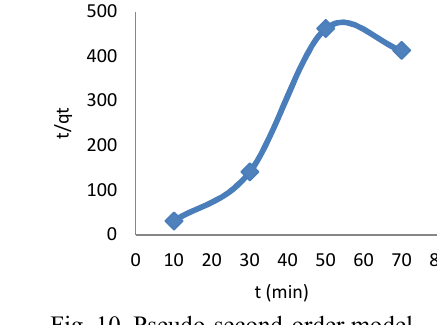
Fig. 9. Pseudo-first-order model Fig. 10. Pseudo-second-order model Table 3. Rate of adsorption kinetic model constants for copper ion removal Pseudo-first order Pseudo-second